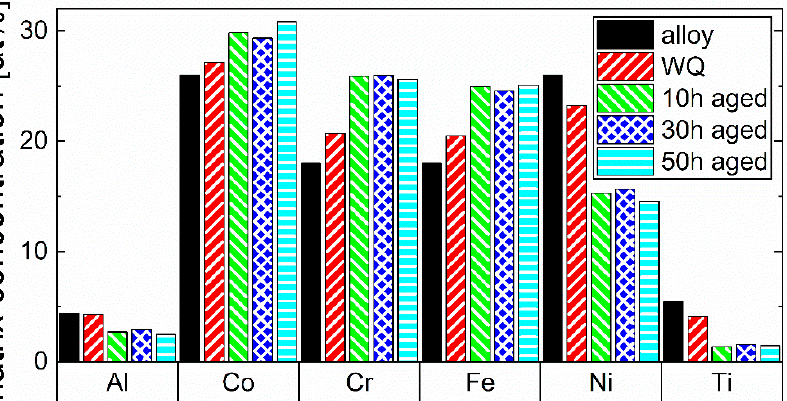
Figure 7. Comparison of the nominal alloy composition (alloy) with the chemical compositions of the matrix phase in the WQ and the three aged states (all after homogenization and annealing) of the CCA. A depletion of Al, Ti, and Ni and an accumulation of Co, Cr, and Fe can be seen in the matrix phase with aging.